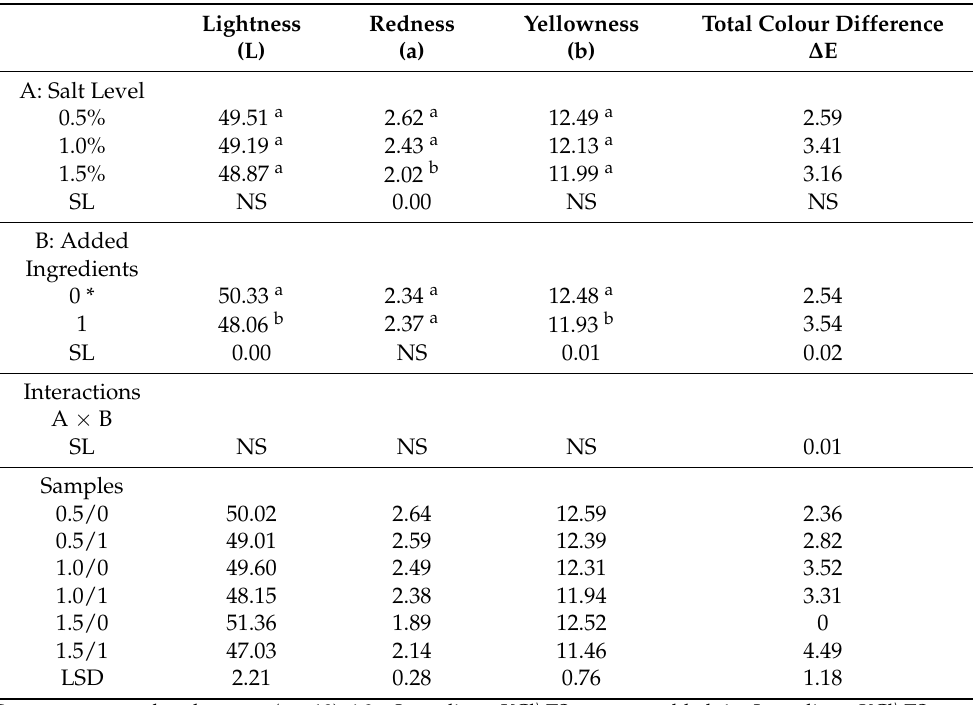
Table 6. The effect of salt levels and added ingredients KCl \ TS on the internal colour of cooked breakfast sausages manufactured with pork belly meat high pressure treated at 150 MPa.